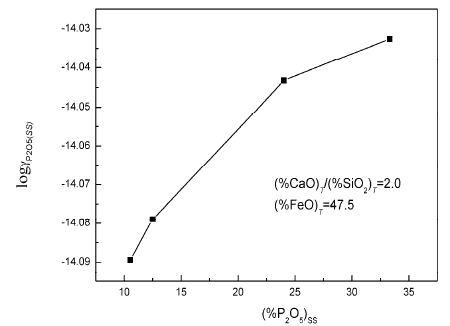
γ . . γ 2 O 5 ( SS ) . 2 5 (SS) P O 2 5 (SS) P O